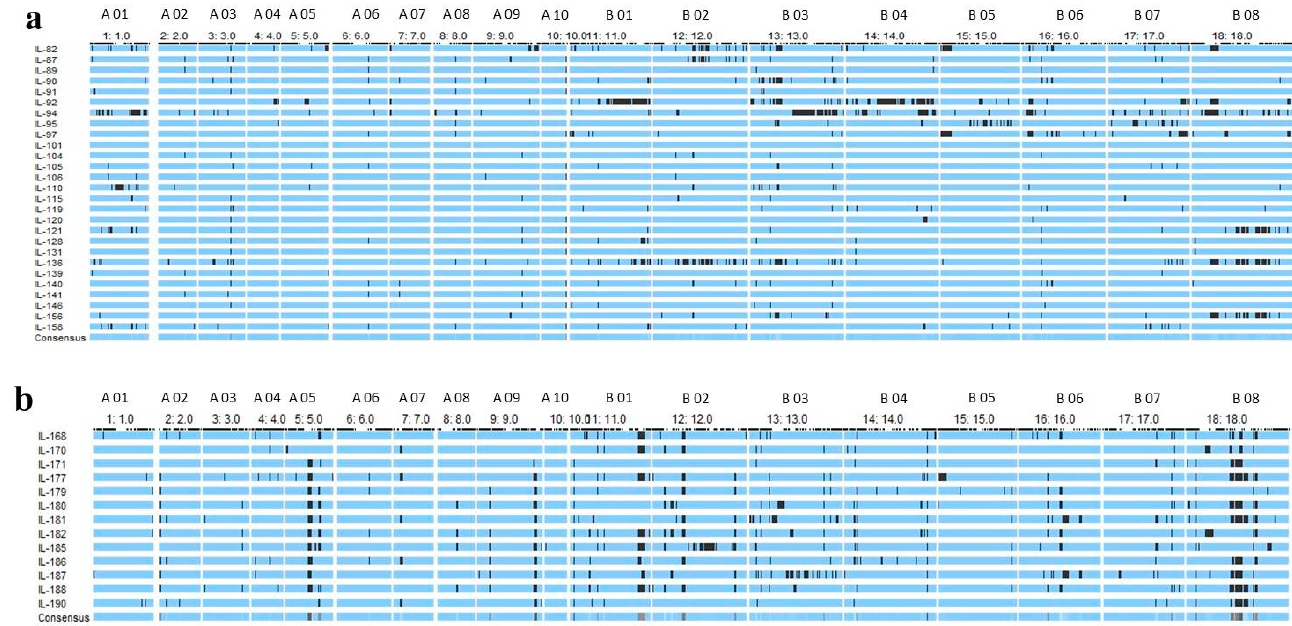
Figure 3. ( a ) Graphical representation of 27 ILs of DRMRIJ 31 showing proportion of donor genome (BC-4) in black colour ( b ) Graphical representation of 13 ILs of Pusa Mustard 30 showing proportion of donor genome (BC-4) in black colour (X axis represents chromosome wise distribution of introgressed segments and Y axis represents graphical genotyping of each IL).